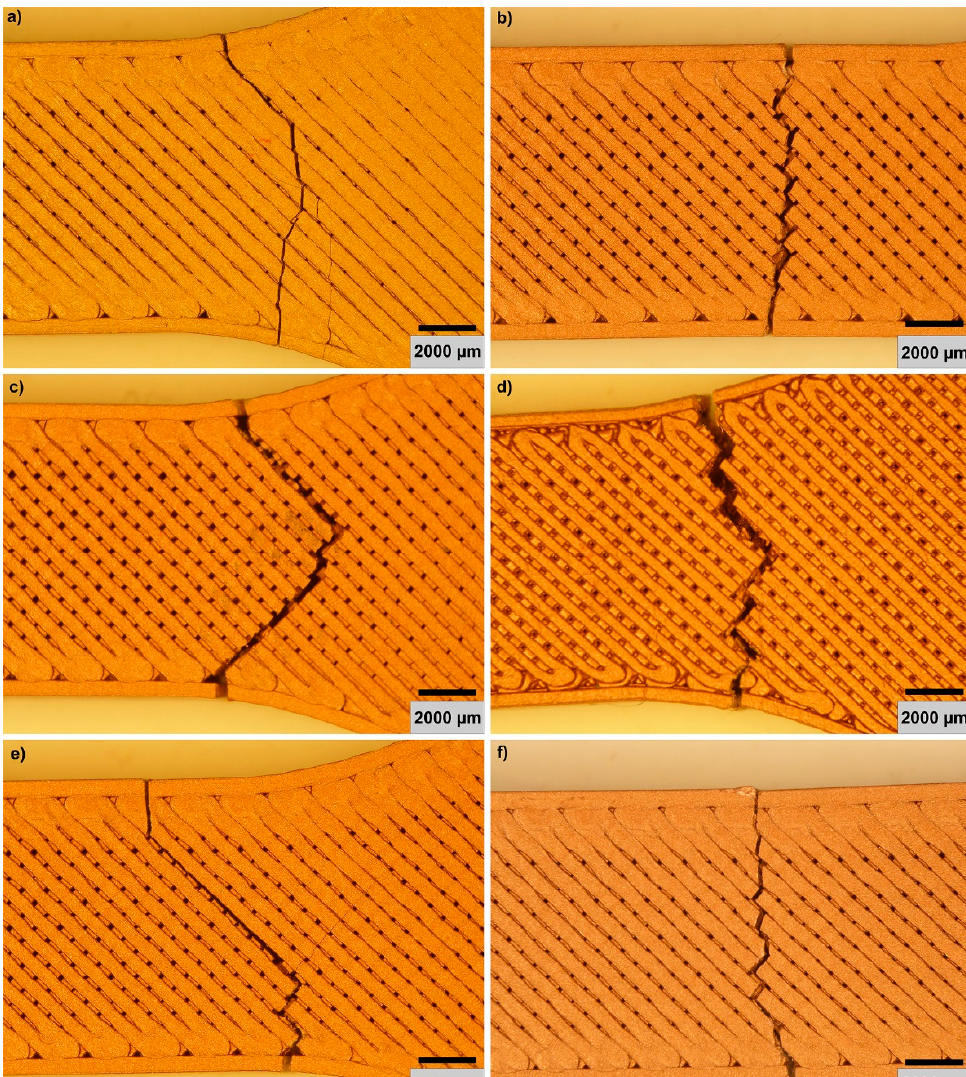
Figure 5. Macrostructural aspects at stereomicroscope of polylactic acid material with copper particles in longitudinal cross section, with different 3D printing parameters: ( a ) 60% interior fill percentage and 45 ◦ thread deposition; ( b ) 60% interior fill percentage and 60 ◦ thread deposition; ( c ) 80% interior fill percentage and 45 ◦ thread deposition; ( d ) 80% interior fill percentage and 60 ◦ thread deposition; ( e ) 100% interior fill percentage and 45 ◦ thread deposition; ( f ) 100% interior fill percentage and 60 ◦ thread deposition.